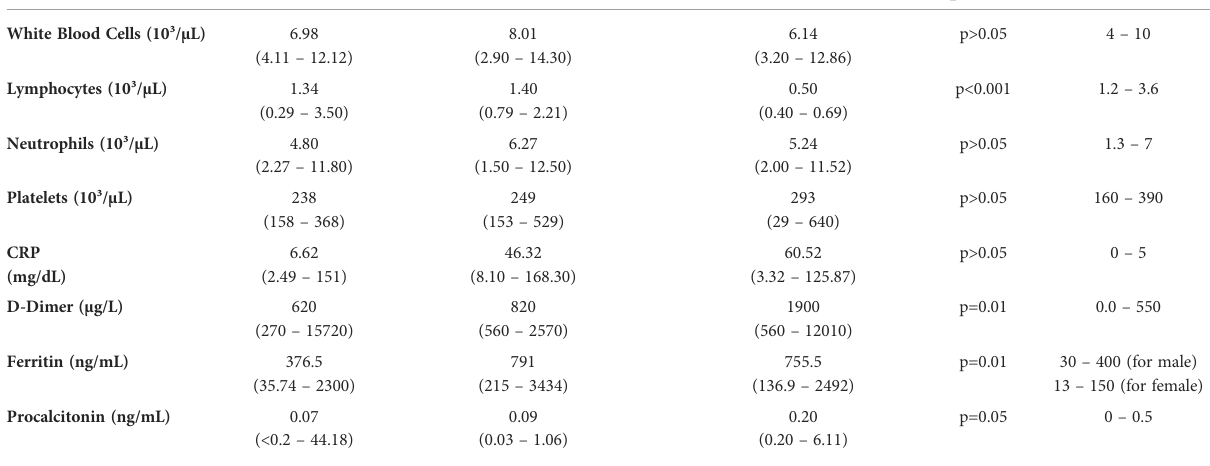
TABLE 2 Biochemical parameters of